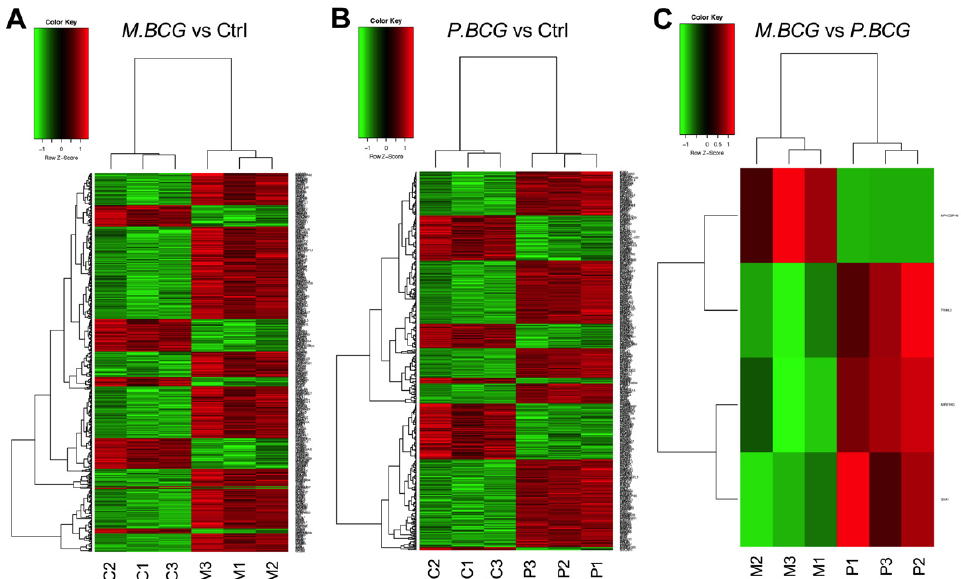
Figure 3. Heatmap representation of differentially expressed genes in THP-1-derived macrophages: ( A ) M.BCG vs. Ctrl; ( B ) P.BCG vs. Ctrl; ( C ) M.BCG vs. P.BCG. Negative z-score indicates subexpressed genes (green), and positive z-score indicates overexpressed genes (red). Genes without significant expression are marked in black. The dendrogram on the left shows the relationship between the genes. M.BCG: Mycobacterium bovis Mexico; P.BCG: Mycobacterium bovis Phipps; Ctrl: control. Table 1. Gene set enrichment analysis in M.BCG compared against the control. ES: Enrichment